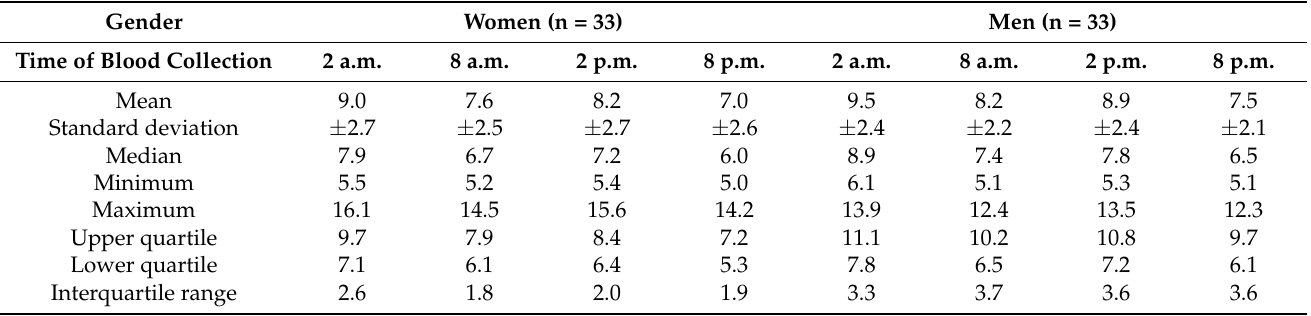
Figure 6. Average erythrocytes activity of GST in men and women at different sampling time points. Data presented as mean ± 95% confidence interval. MANOVA ‐ type analysis ( p = 0.67233). Table 8. Parameters describing concentration of glutathione (GSH) in women and men, including the time of blood collection